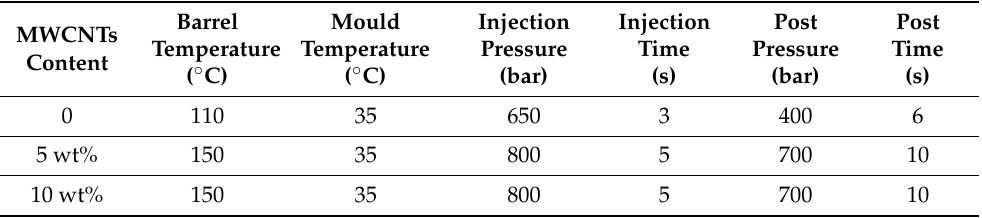
Table 1. Injection moulding parameters for coPA and it’s masterbatches containing 5 wt% and 10 wt%